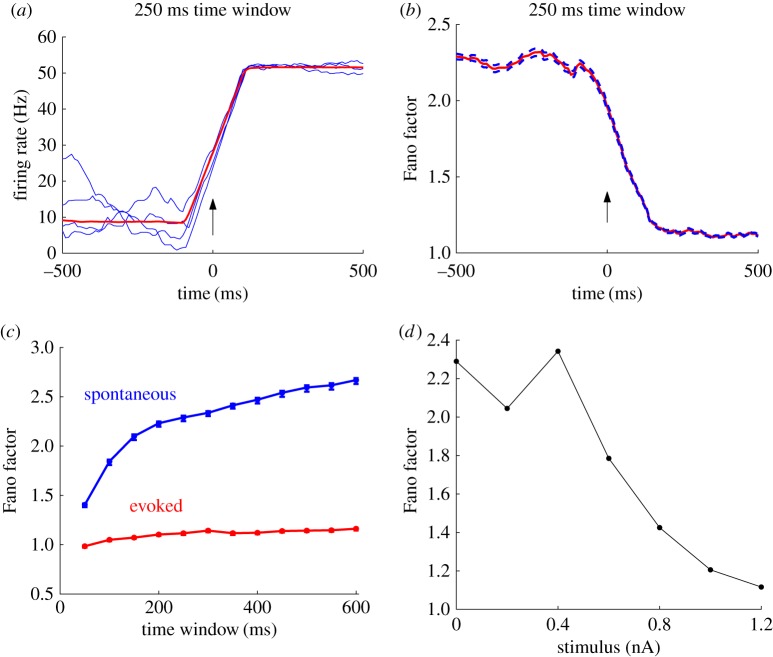
Stimulus onset quenches neural variability. (a) The firing rate, calculated using a Δt = 250 ms sliding time window, averaged over all neurons within the RoI for five individual trials (blue lines) and averaged over all 500 trials as well as all neurons within the RoI (red line). The arrow indicates the stimulus onset time; after the stimulus is switched on, the trial-averaged firing rate increases and individual trials fluctuate much less. (b) Fano factor (red solid line with flanking blue dashed lines denoting standard error), which is calculated using a Δt = 250 ms sliding time window and averaged over all neurons within the RoI. The arrow indicates the stimulus onset time; after the stimulus is switched on, there is a large decrease in Fano factor value. (c) Fano factor as a function of time window Δt during the spontaneous activity (blue line) and after stimulation (red line). For Δt≥150 ms during the spontaneous activity, Fano factor increases linearly with time window; after the stimulus is applied, the Fano factor remains the same value regardless of the choice of Δt. (d) Fano factor, calculated using a Δt = 250 ms sliding time window and averaged over all neurons within the RoI, as a function of stimulus strength; for larger stimulus strengths, there is a monotonic decrease in Fano factor.